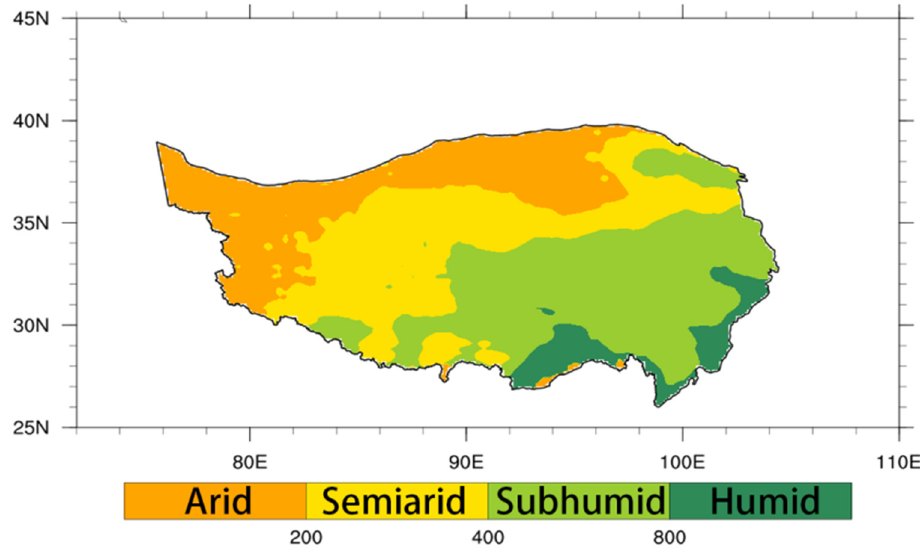
Figure 12. Climate zones on the Tibetan Plateau.